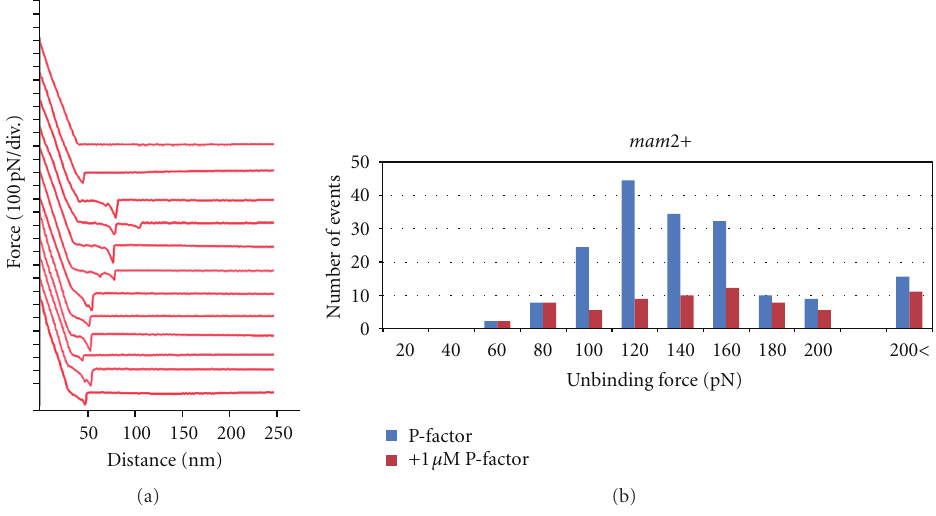
Figure 2: (a) Typical retraction force curves between P-factor and the cells. Vertical axis indicates cantilever deflections as a function of the cantilever-sample retraction distance. The first curve from the top shows no interaction, and the other curves display specific unbinding events between peptide and the cell. The vertical force jump of events allows access to the specific unbinding force. (b) Force histogram of unbinding events (blue columns) obtained after analysis of 1024 force curves. The mean unbinding force is 120pN, for a mean loading rate of 1.74 μ m/s. In the presence of free 1 μ M P-factor, the number of unbinding events decreased (red